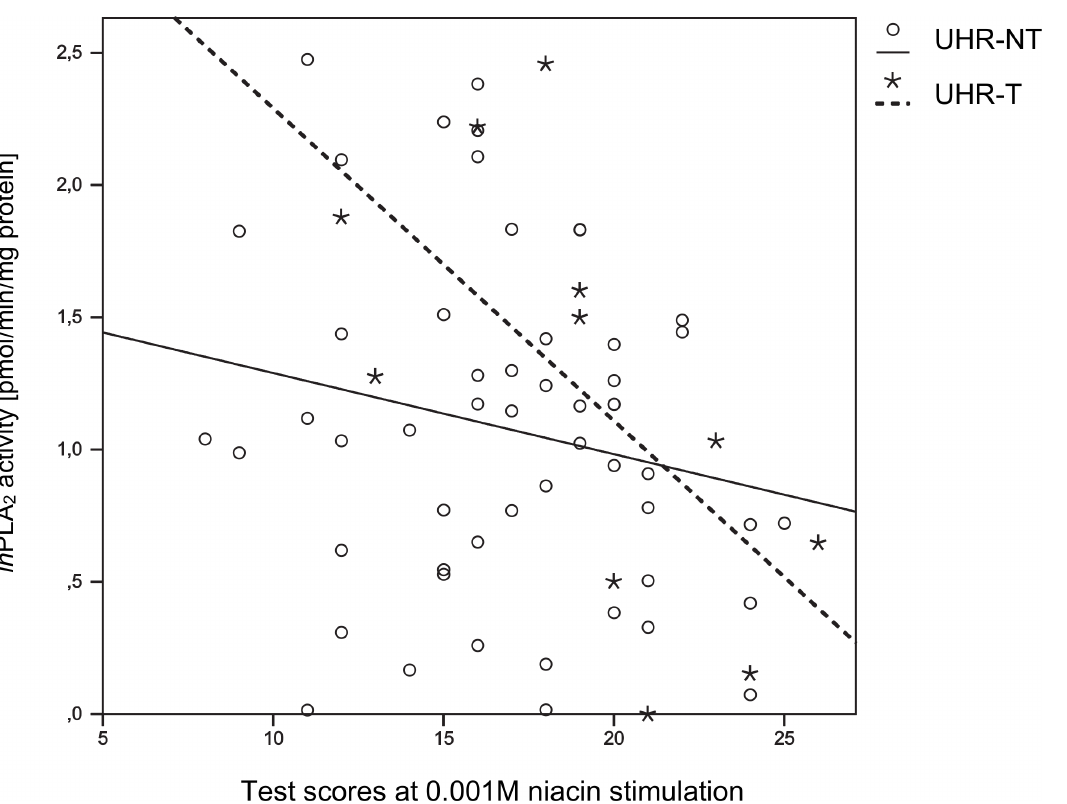
Fig 2. Results of correlation analysis between niacin sum scores at 0.001M stimulation and in PLA2 activity in UHR-NT- and UHR-T individuals.